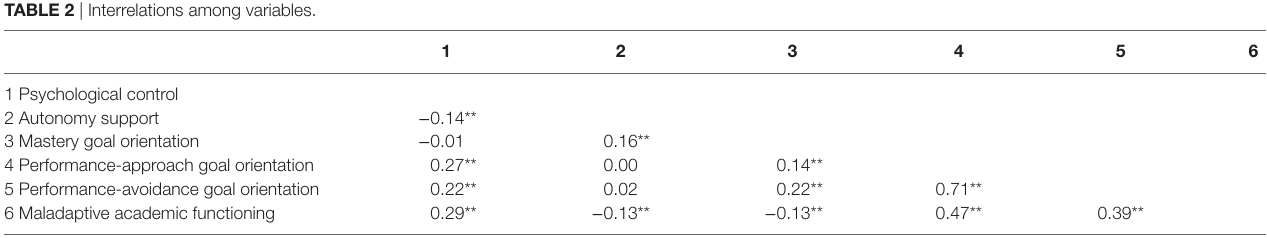
Table 2 | Interrelations among variables.